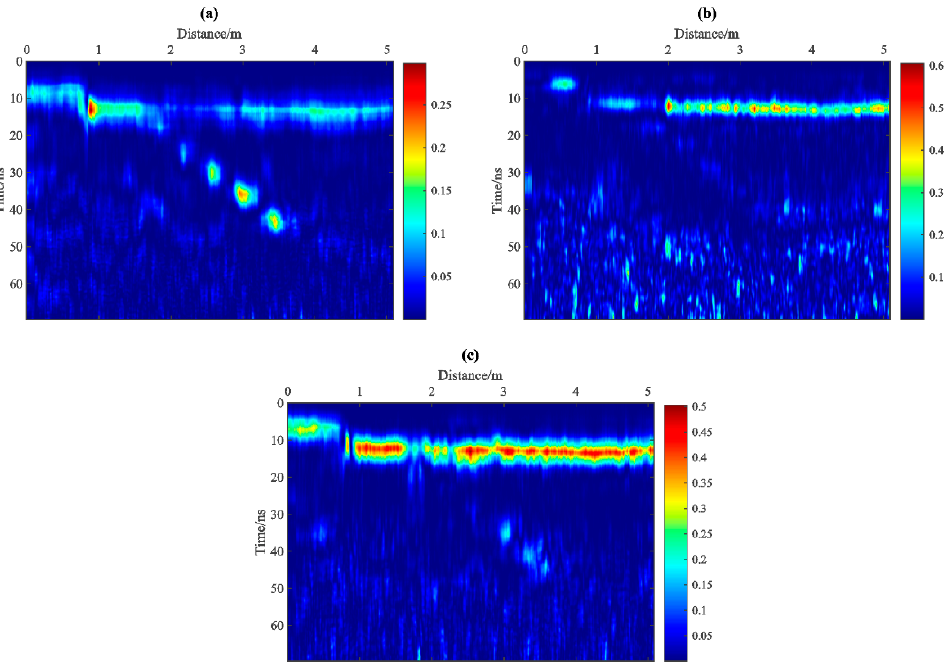
Figure 15. The instantaneous amplitude profiles of IMF-slices 1 − 3 ( a − c ) for the field data by using MVMD, respectively.